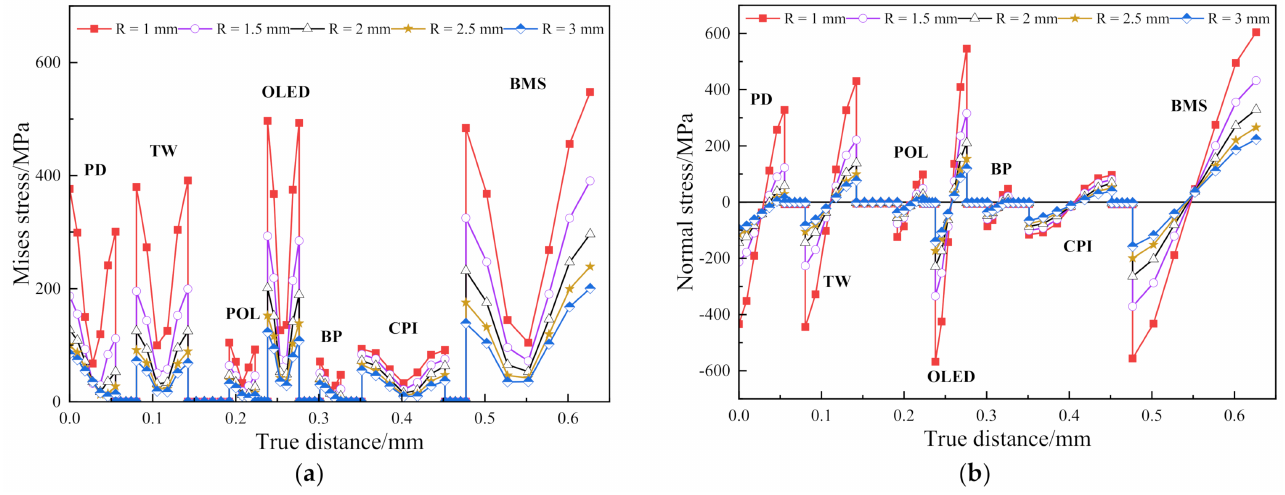
Figure 4. ( a ) Mises stress distribution along the central axis at different bending radii; ( b ) contrast curve of normal bending stress of the central axis at different bending